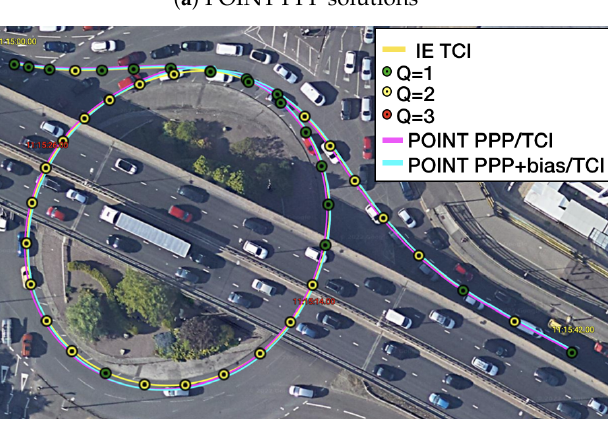
Figure 20. Re-convergence example 2 on Google Earth.